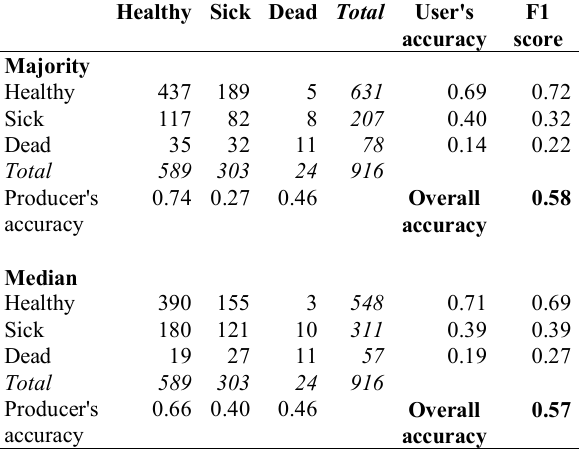
Table 3. Error matrices with the majority and median of the pixel values, classified with RENDVI and